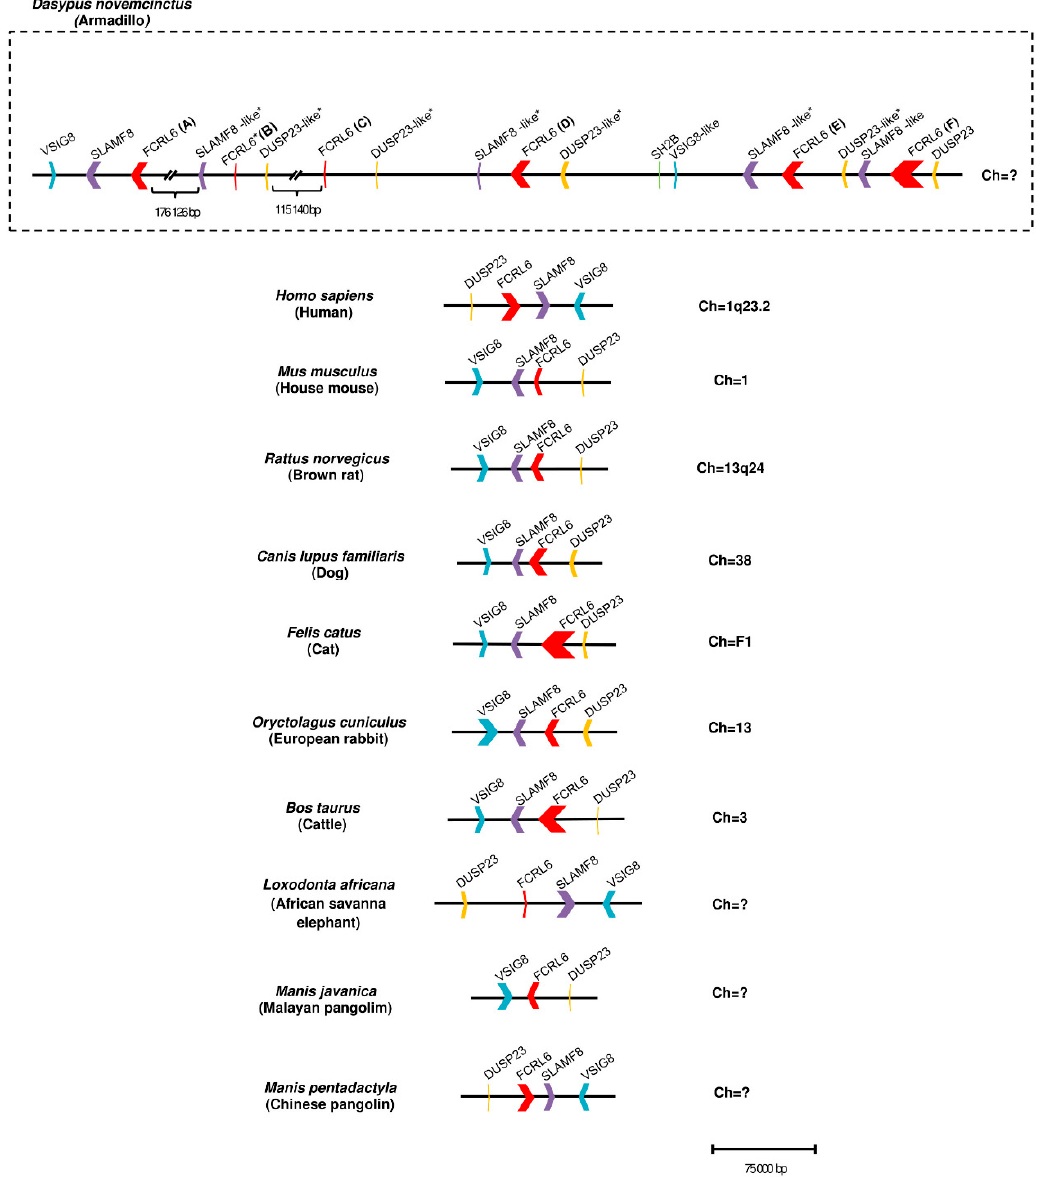
Figure 1. Structure of the FCRL6 locus among 11 mammalian genomes. Horizontal lines correspond to the chromosome on which FCRL6 and its flanking genes are located. Genes are color-coded: FCRL6 (red), SLAMF8 (purple), VSIG8 (blue), DUSP23 (yellow) and SH2B (green). Pseudogenes are labelled with an asterisk (*). Table 2. Proposed nomenclature for FCRL6 gene copies in D. novemcinctus .